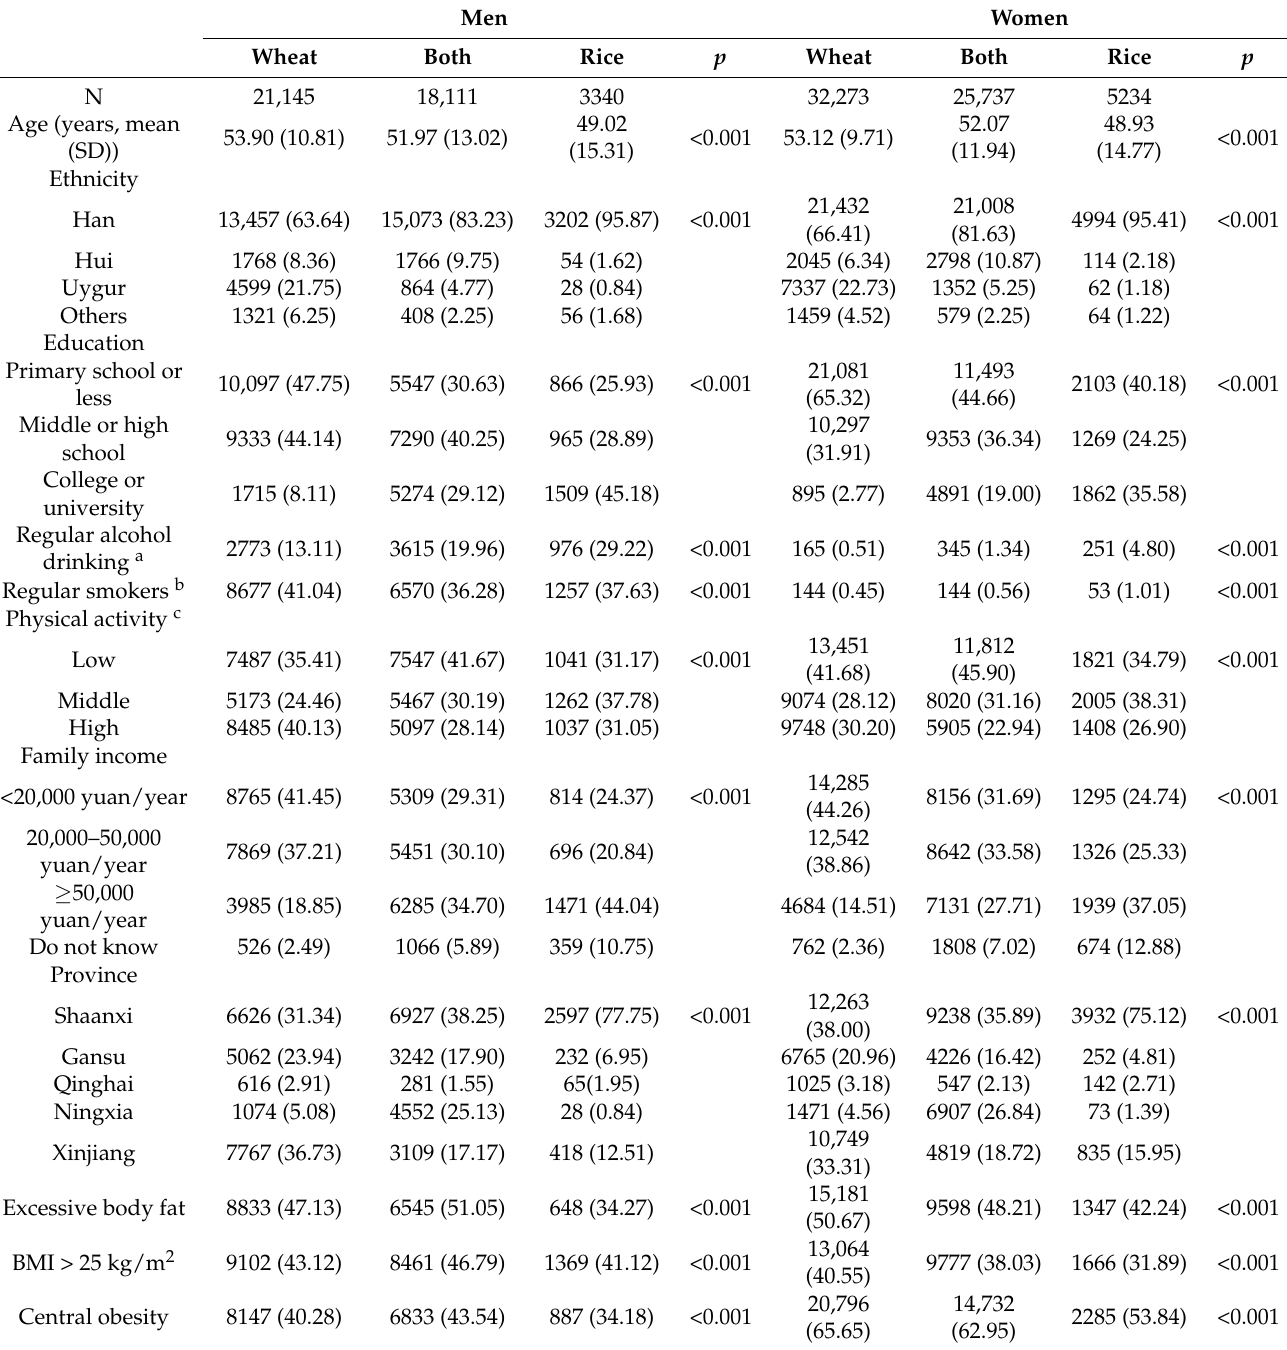
Table 1. Characteristics of the participants by staple food preference and